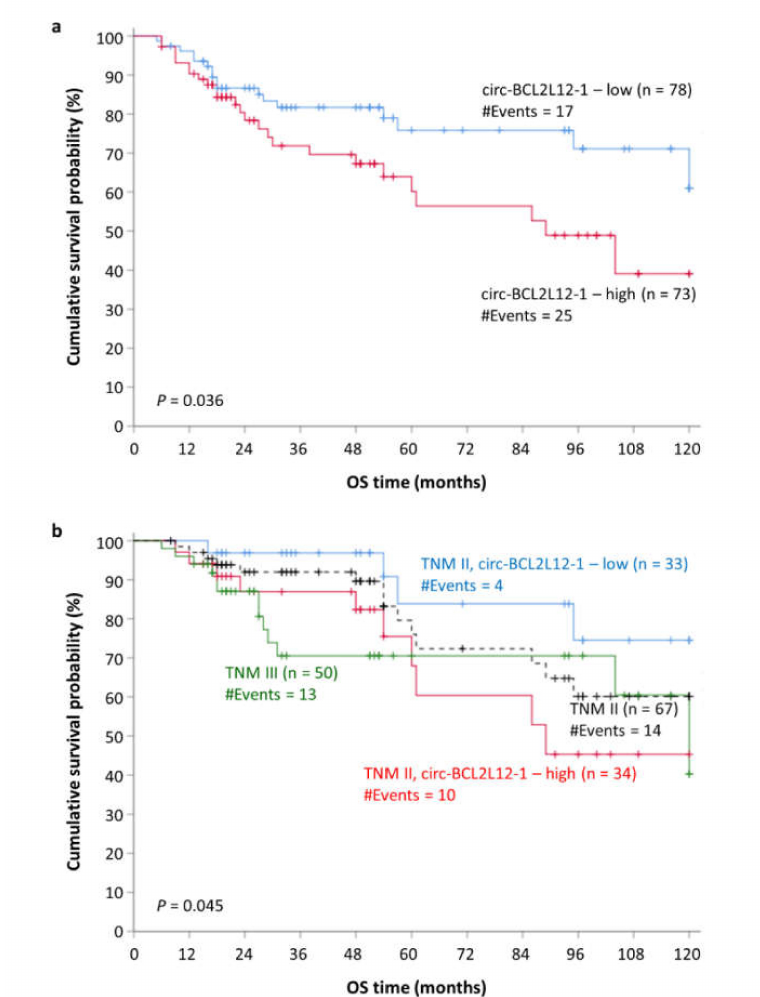
Figure 4. Kaplan–Meier overall survival (OS) curves for CRC patients. ( a ) All CRC patients, categorized according to circ-BCL2L12-1 expression; circ-BCL2L12-1–high patients showed significantly poorer OS compared to the circ-BCL2L12-1–low ones. ( b ) TNM stage II patients, categorized according to circ-BCL2L12-1 expression; circ-BCL2L12-1–high patients showed significantly poorer OS compared